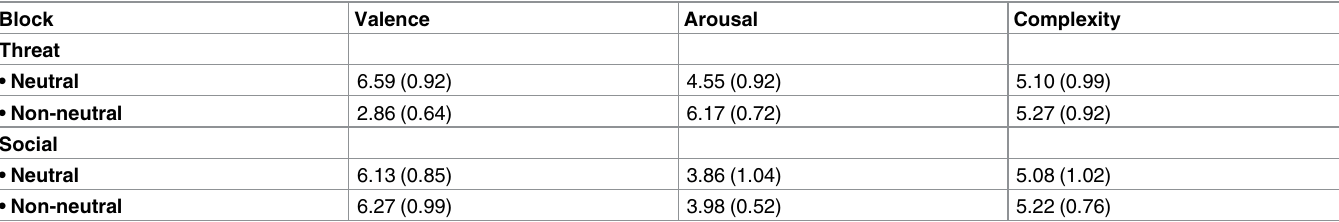
Table 1. Mean ratings of valence, arousal and complexity for neutral and non-neutral stimuli in each block (SD in parentheses).